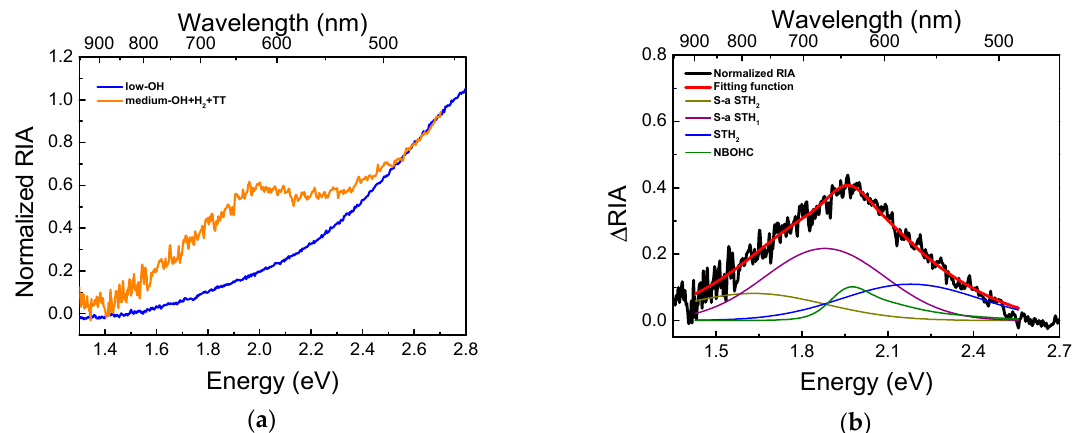
Figure 9. ( a ) Normalized spectra with respect to the RIA measured at 2.8 eV (450 nm) for the low - and the treated medium -OH samples at 10 kGy dose. ( b ) Fitting function obtained for the difference of the normalized RIA of the treated medium - and low -OH samples measured at a dose of 10 kGy. Table 3. Best-fit parameters for the RIA at 10 kGy of the treated and not-treated medium- OH sample. Point Defect